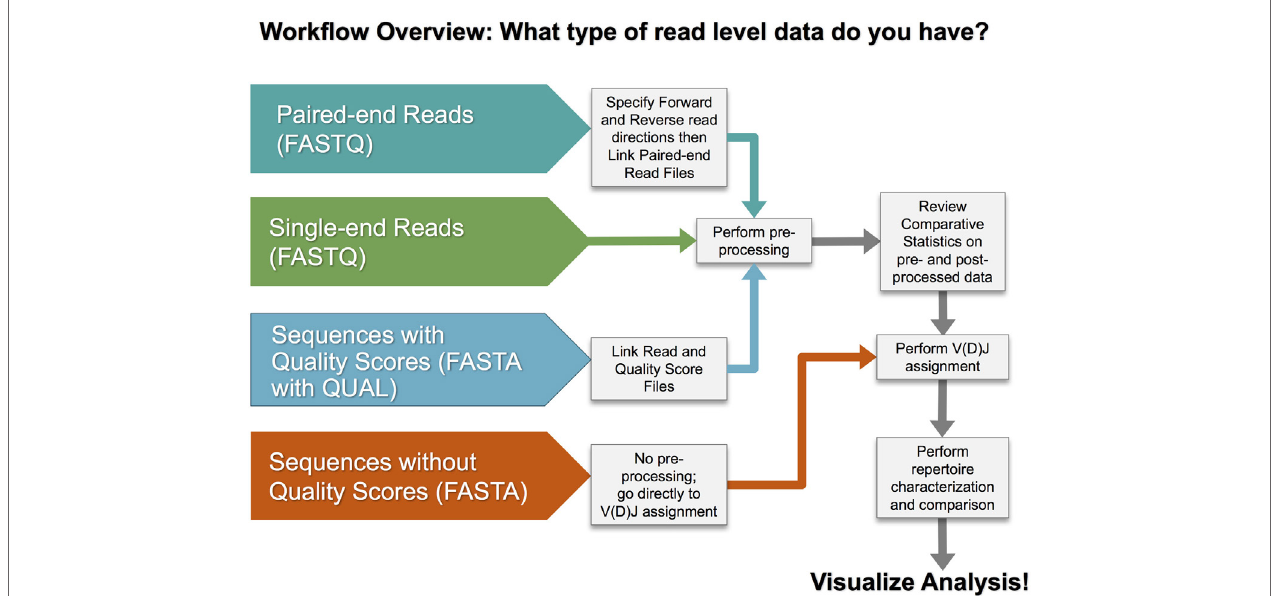
FIguRe 3 | VDJServer analysis workflow